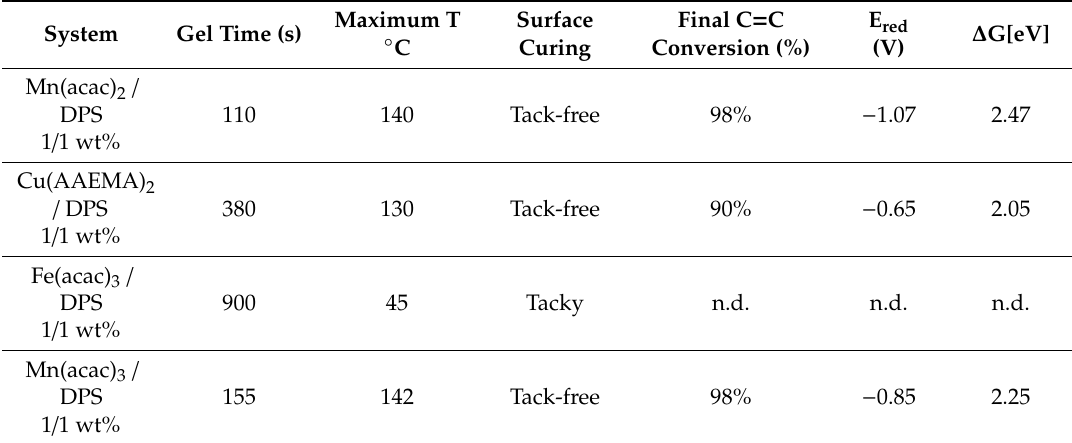
Table 1. Data of polymerization using di ff erent redox systems for the benchmark monomer blend.